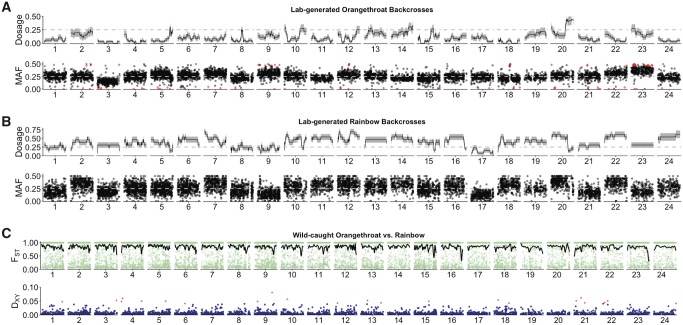
Mean minor parent allele dosage (“Dosage”) and minor allele frequency (“MAF”) along each linkage group for (A) 36 orangethroat backcross fry and (B) 13 rainbow backcross fry. The minor parent allele dosage was calculated using a Hidden Markov Model implemented in ELAI. ELAI inferred ancestry along each linkage group for each backcross fry using a set of 29,064 SNPs. In backcrosses, the minor parent allele dosage can range from 0.0 to 1.0 for a given linkage group (see fig. 1B), and the mean minor parent allele dosage is expected to be 0.25. An allele dosage of 1.0 indicates perfect heterozygosity, with one allele originating from the minor parent and the other from the major parent. An allele dosage of 0.0 represents nonadmixed regions of the genome with zero minor parent alleles (and two major parent alleles). SE around the mean allele dosage is shown in gray. MAF is shown for a set of 8,177 SNPs. SNPs that deviate significantly from the expected MAF of 0.25 are shown in red (5% FDR). (C) FST and DXY were calculated between 10 wild-caught orangethroat darters and 14 wild-caught rainbow darters at 43,502 SNPs across the genome. FST for the 39,518 SNPs that mapped to 1 of the 24 linkage groups is shown in green. Smoothed FST (black line) was calculated in sliding 500 kb windows. DXY was calculated in nonoverlapping 50 kb windows, resulting in a total of 3,443 windows covering 0.81 million sites across the genome. DXY windows mapping to 1 of the 24 linkage groups (3,062 total) are shown, with outlier windows above the 99th percentile (DXY>0.0407) in red.